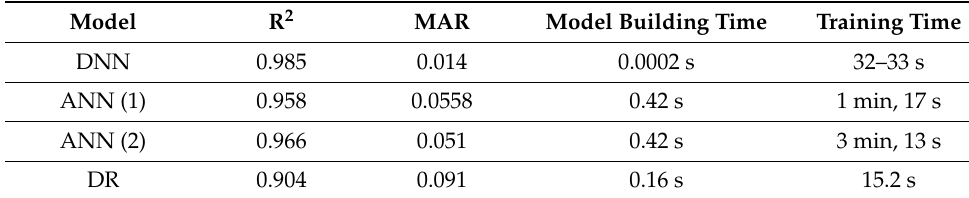
Table 6. Comparison between DNN, ANN, and